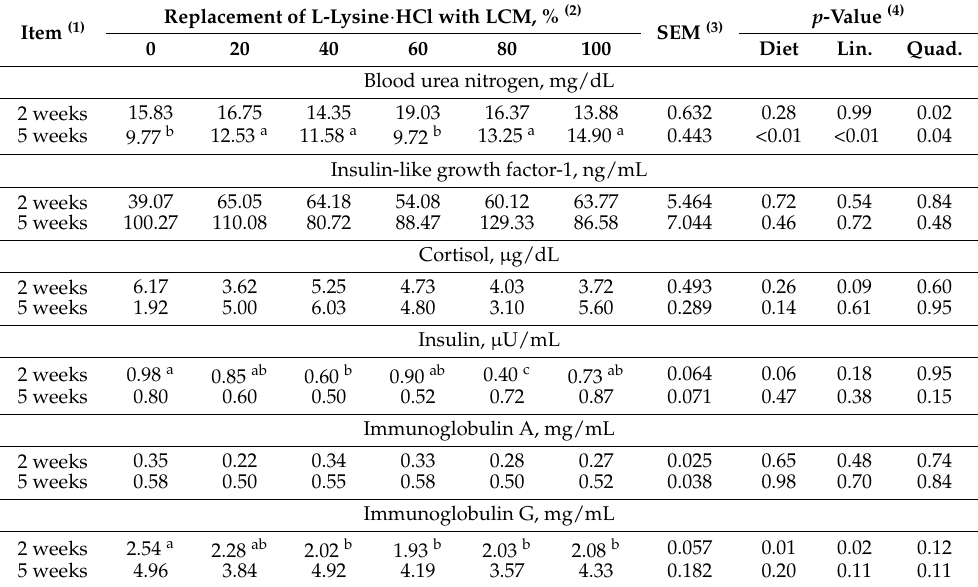
Table 10. Effects of LCM supplementation levels on blood profiles in weaning pigs (exp.